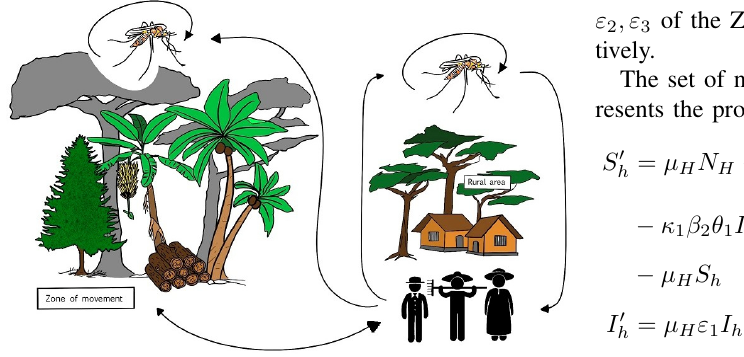
riod of time, so we assume the total human population remains constant: S h + I h + R h = N H . tion ( S v , I v ) and the nearby forest population ( S u , I u ). The overall vector populations at time t are S v + I v = N V and S u + I u = N U . Rural and forest mosquitoes are assumed to be only infected by infectious